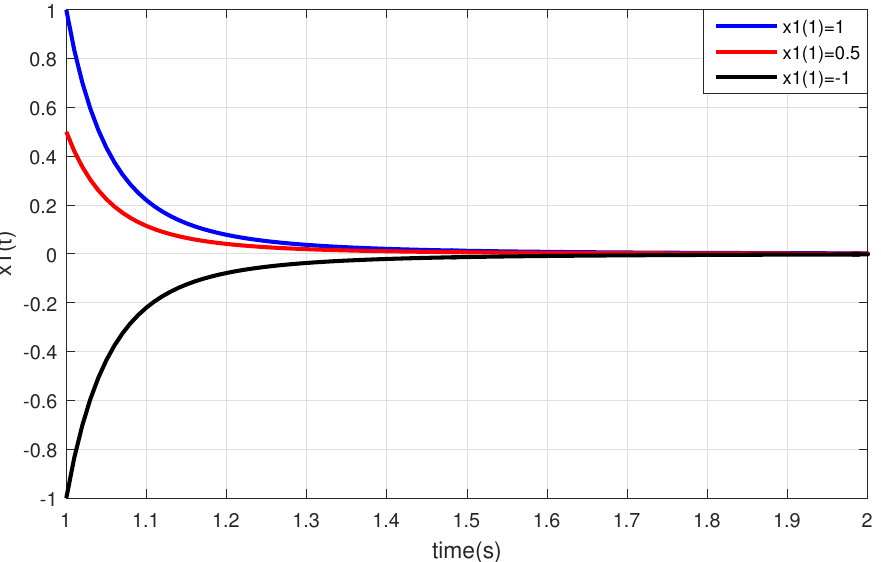
Figure 3. This figure shows that the solution x 1 ( t ) of the perturbed nonlinear system of DDEs (14) with three time-varying delays is bounded for h 1 ( t ) = 1 t ≥ 1, and different initial values.